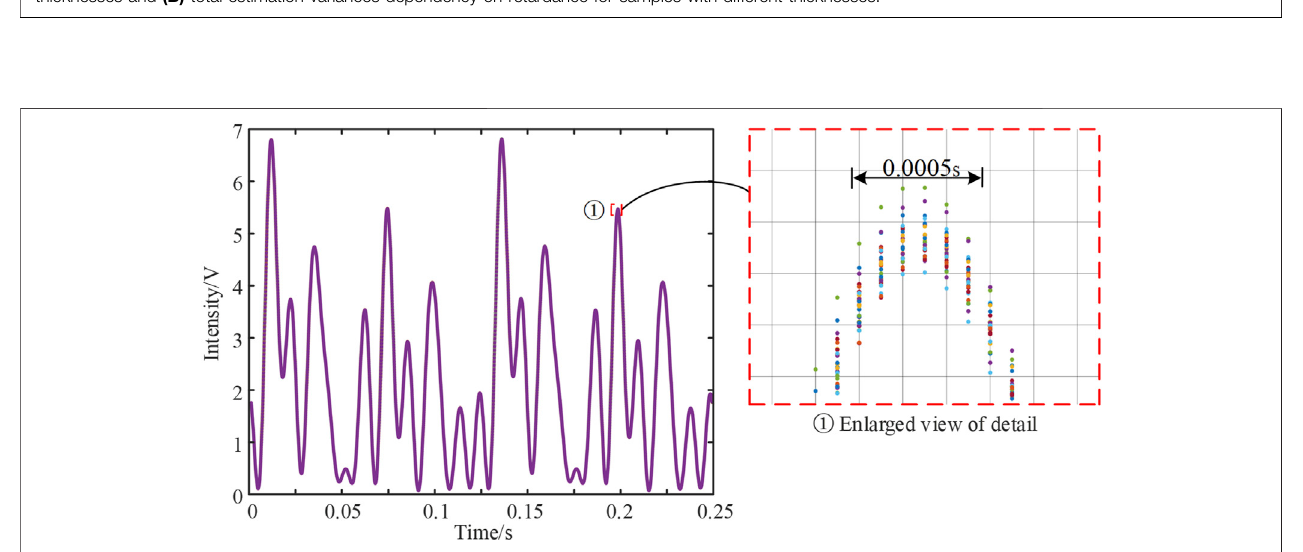
FIGURE 10 | Signal waveform after using peak-matching